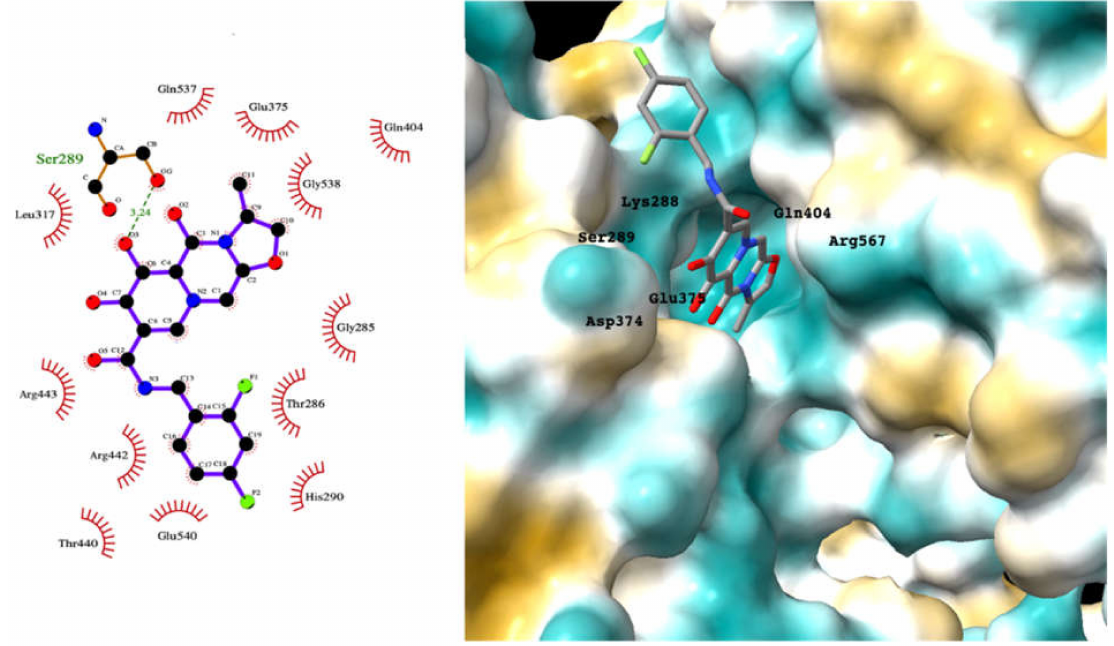
Figure 4. LigPlot ( left ) shows the key active site residues interacting with cabotegravir. The molecular model ( right ) shows the binding of cabotegravir to the active site cleft of the helicase. The tricyclic ring moiety is deeply embedded in a hydrophilic pocket. The molecular surface denotes hydrophobicity of the pockets (blue hydrophilic, yellow/brown hydrophobic). Positions of key binding site residues are